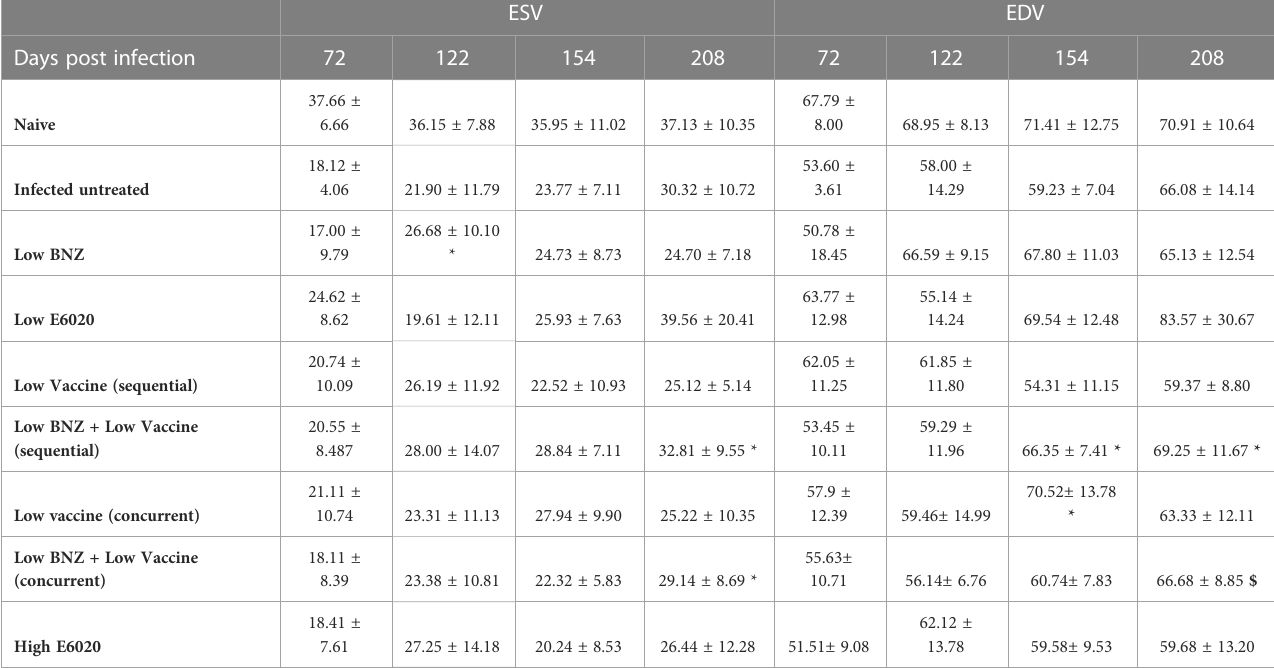
TABLE 3 Left ventricular